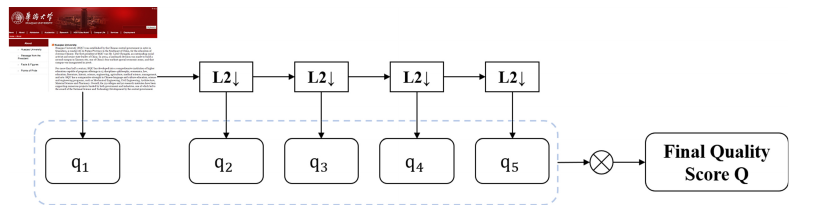
Figure 2. The framework of the proposed IQA method for SCIs. L2 ↓ : down-sampling by factor 2 with low-pass filter. q1, q2, q3, q4, and q5: quality score of scale 1, 2, 3, 4, and 5. ⊗ : weighted fusion.